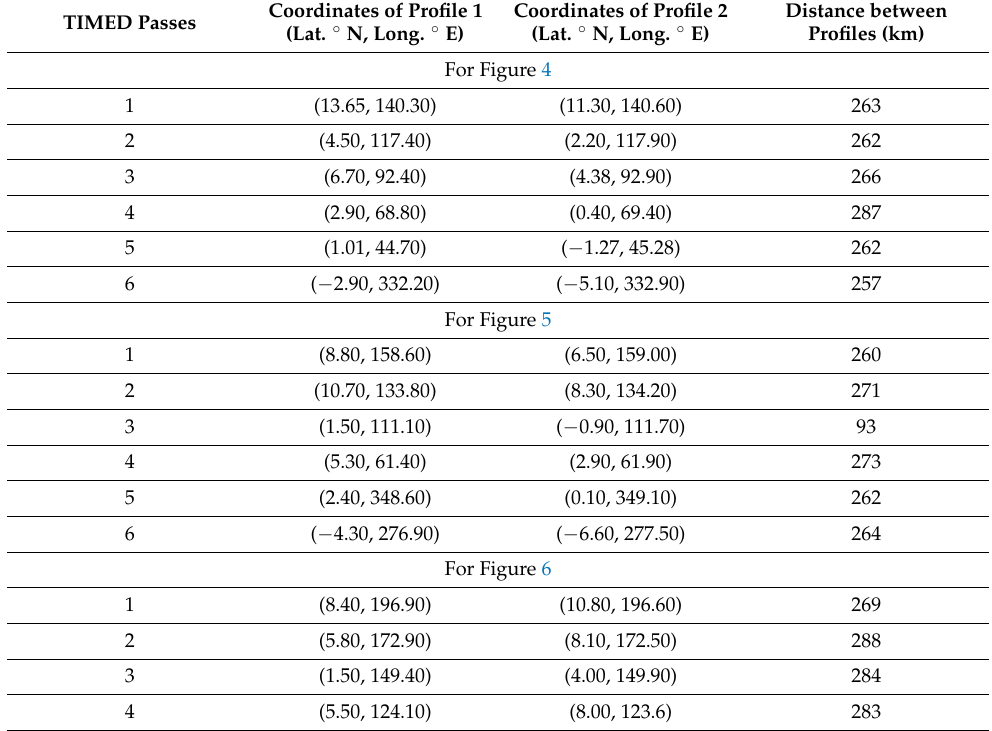
Figure 6. Temperature profiles ( left panels ), normalized temperature fluctuations ( 2nd column from the left ), contour maps of WPS versus vertical wavelength and altitude for the two profiles ( 3rd and 4th columns from the left , deep red and blue colors represent respectively the dominant and lowest power), and normalized GWPS versus vertical wavelength ( right column ) corresponding to four orbits of SABER satellite on14 October 2011. Table 1. Geographic latitude and longitude and separation distances of pairs of temperature